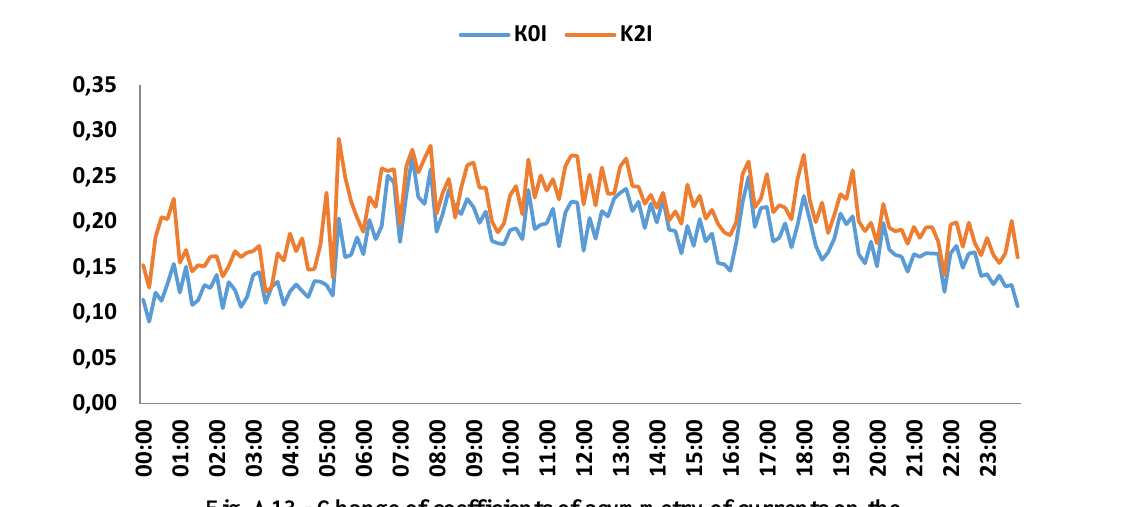
Fig. A13 - Change of coefficients of asymmetry of currents on the negative and zero sequences of the apartment